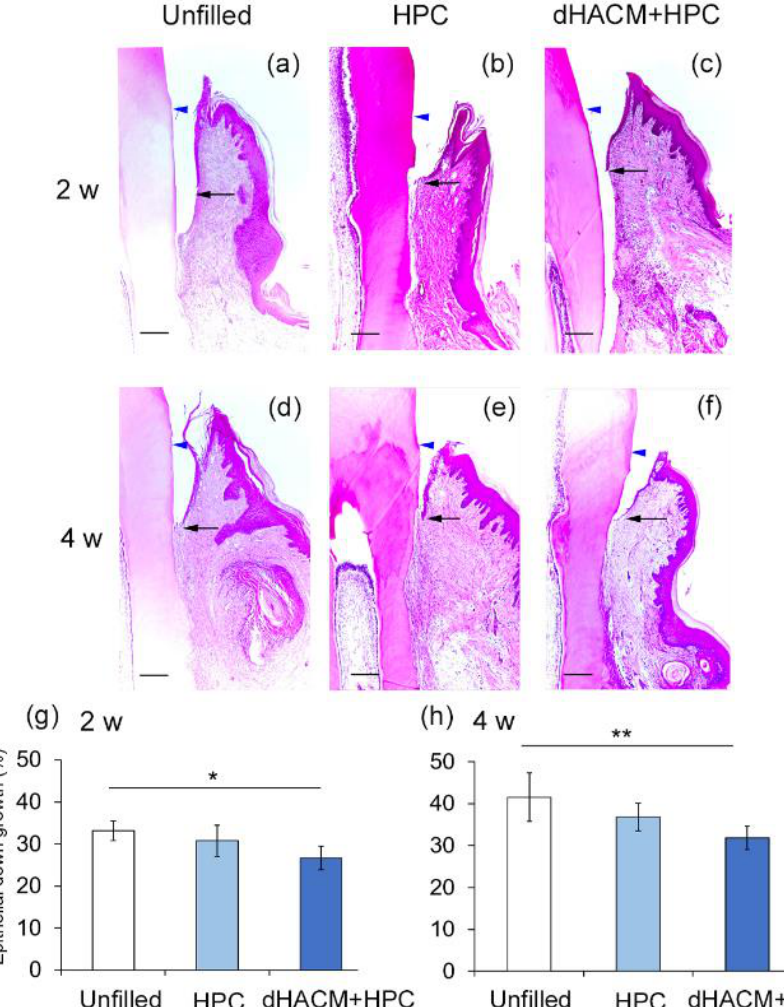
Figure 3. Histological assessment of epithelial down-growth. ( a – f ) The apical extent of epithelial down-growth (indicated by arrows) was compared at 2 and 4 weeks. Blue arrowheads indicate cemento-enamel junction (CEJ). ( a , d ) At 2 weeks, epithelial down-growth along the root surface in the dHACM+HPC group appears to be less than that in the Unfilled group (original magnification ×50; bar = 200 µ m). ( g , h ) Data shown as mean ± SD ( n = 6) of (the length between the most coronal and most apical aspects of the junctional epithelium on the root surface)/(the distance between CEJ and the bottom of the defect) (%) at 2 and 4 weeks. * p < 0.05, ** p < 0.01, by Kruskal–Wallis test with Dunn’s post hoc test.